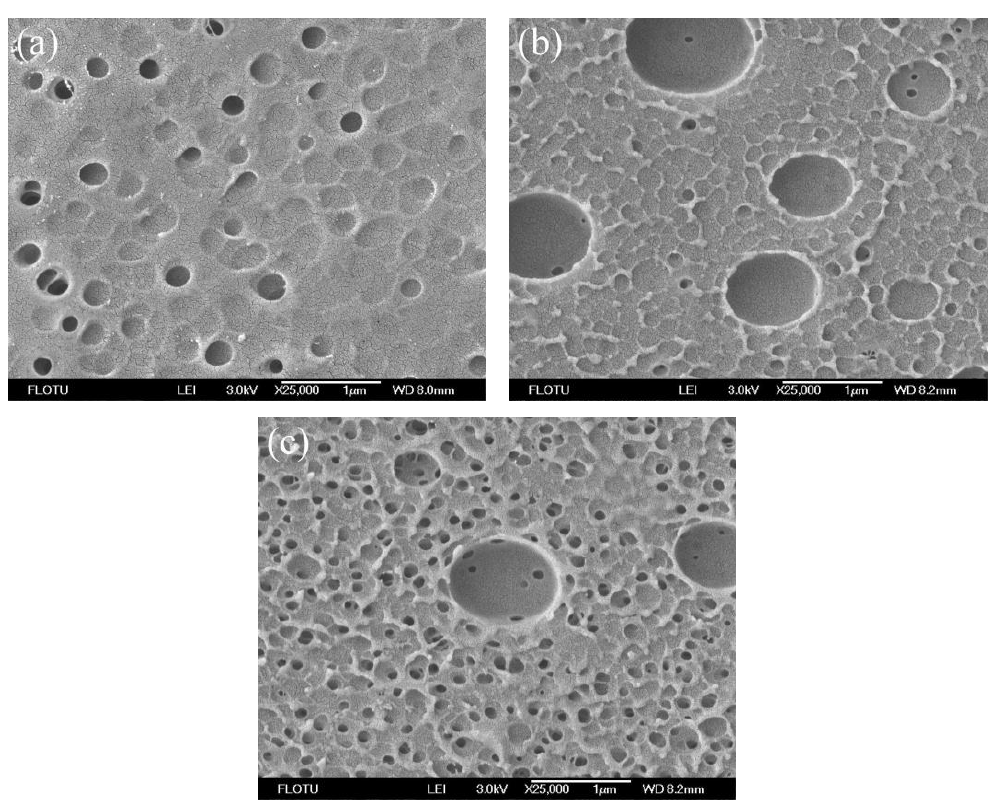
Figure 2. SEM photomicrographs of neat PPSU membranes: ( a ) cross-section; ( b ) top surface.